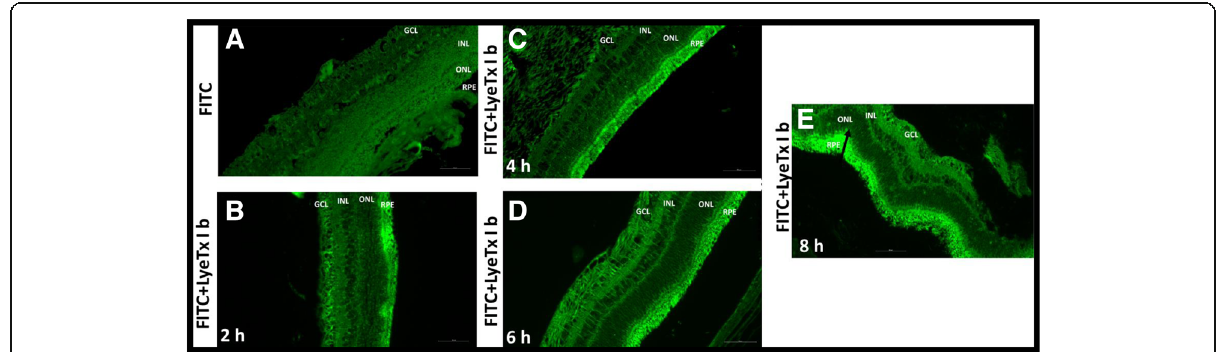
Fig. 2 LyeTx I b – FITC intravitreal penetrates the retina. a The retina layers without peptide. b Retina layer 2 h after intravitreal injection of LyeTx I b - FITC (2.89 μ M). c 4 h after intravitreal injection. d 6 h after intravitreal injection. e 8 h after intravitreal injection. RPE- Retinal Pigment Epithelium, ONL- Outer nuclear layer, INL- Inner nuclear layer, GCL-Ganglion cell layer. Digital images were obtained using a microscope (Apotome.2, ZEISS, Germany) equipped for epifluorescence and a standard fluorescein filter with a 20× objective. FITC was excited at 490 nm and presented emission at 526 nm